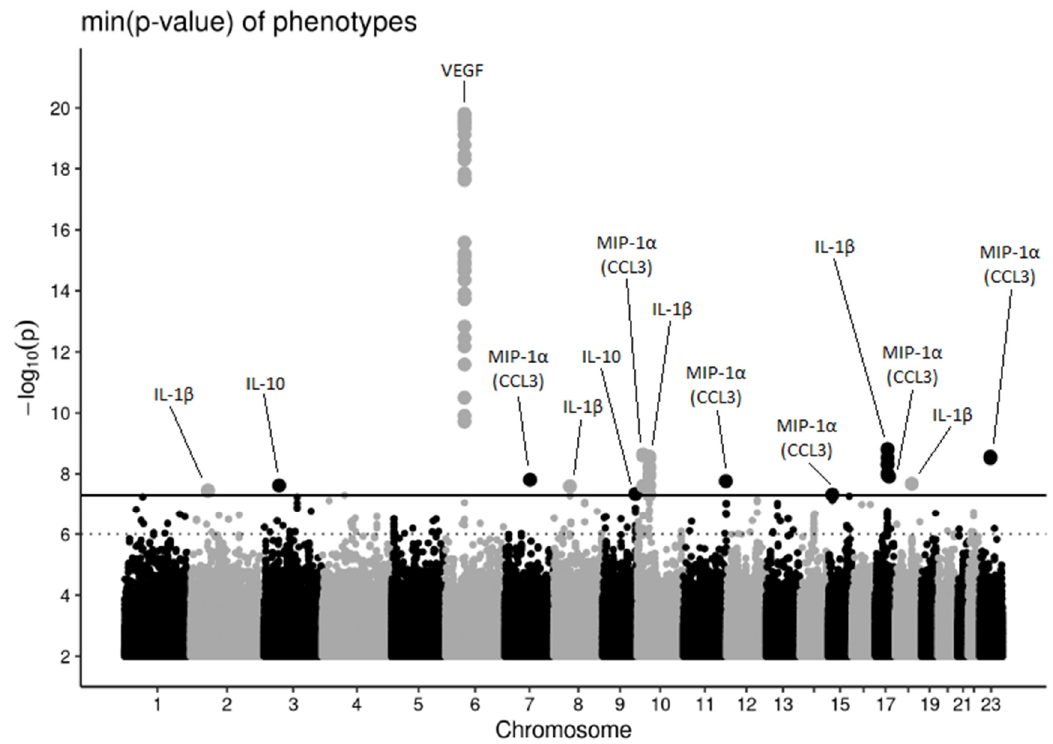
Figure 1. Manhattan plot showing association results of the ten considered cytokines. For each SNP the maximum negative log- p -value with respect to all cytokines is shown. The solid line corresponds to the genome-wide significance threshold (5 × 10 − 8 ). The dotted line indicates suggestive associations with a p -value less than or equal to 1 × 10 − 6 for one of the cytokines. Associations could be assigned to 14 distinct loci. Genome-wide significant hits are annotated by their best associated cytokine.